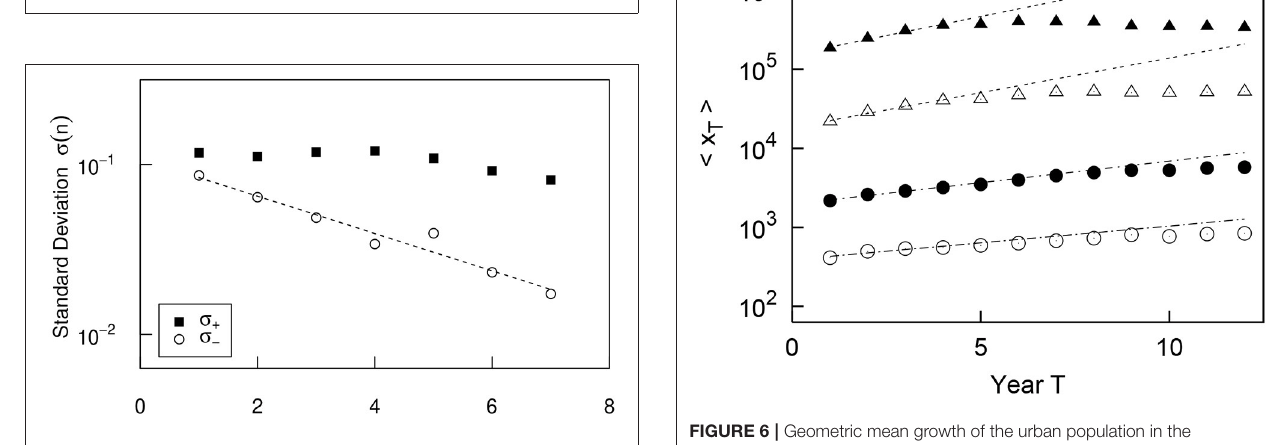
FIGURE 6 | Geometric mean growth of the urban population in the United States from 1900 to 2010 ( T = 1,2, ··· ,12). The original population of x 1 in 1900 ( T = 1) is divided into logarithmically equally sized bins: x 1 ∈ [10 m + 1 ,10 m + 2 ) ( m = 1,2,3), x 1 ≥ 10 5 ( m = 4). In the figure, ◦ , • , △ , and N each represent m = 1,2,3, and 4,